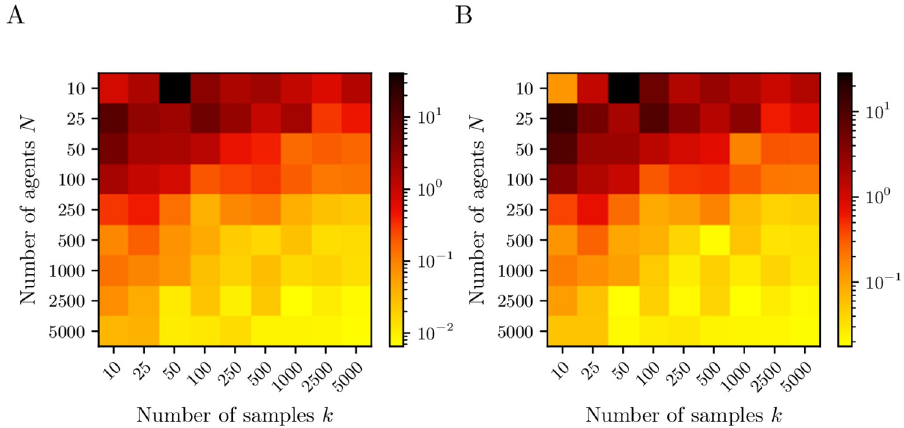
Fig 4. Root mean square error of drift and diffusion coefficients. Approximation error defined as the RMSE of the coefficients of (A) the drift and (B) diffusion estimates for the EVM in Section 3.2 compared to the exact SDE limit model (5) depending on the number of agents N and number of Monte Carlo samples k for the estimation via Kramers–Moyal formulae. The brighter the color, the smaller the error and the better the identification of the reduced system. For increasing N and k the approximation error